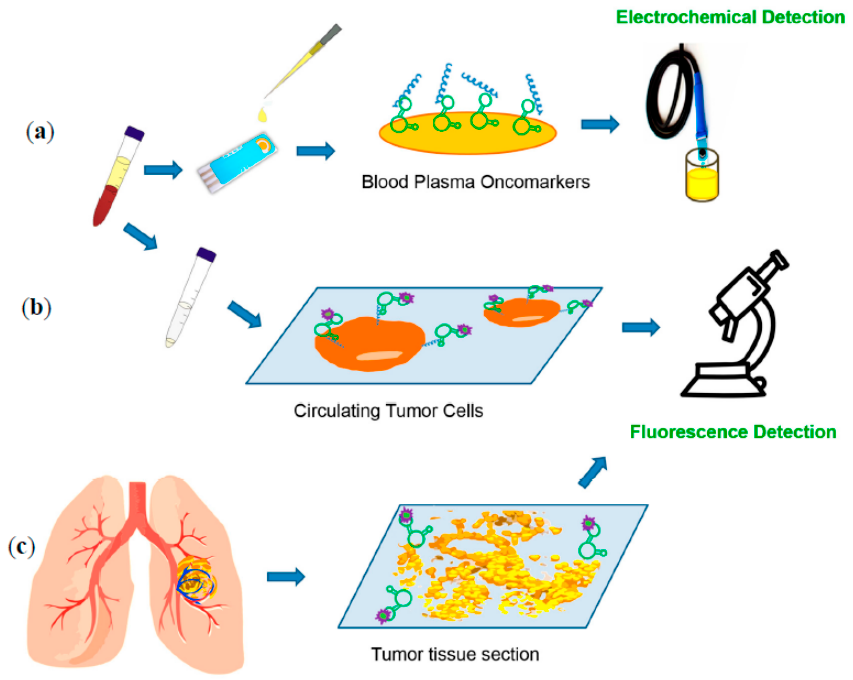
Figure 4. Schematic representation of aptamer-based lung cancer diagnostic tools. ( a ) analyses of blood plasma oncomarkers using electrochemical detection; ( b ) circulating tumor cells capture and fluorescence detection ; ( c ) aptamer based immunohistochemistry-like characterization of lung cancer histological structure.